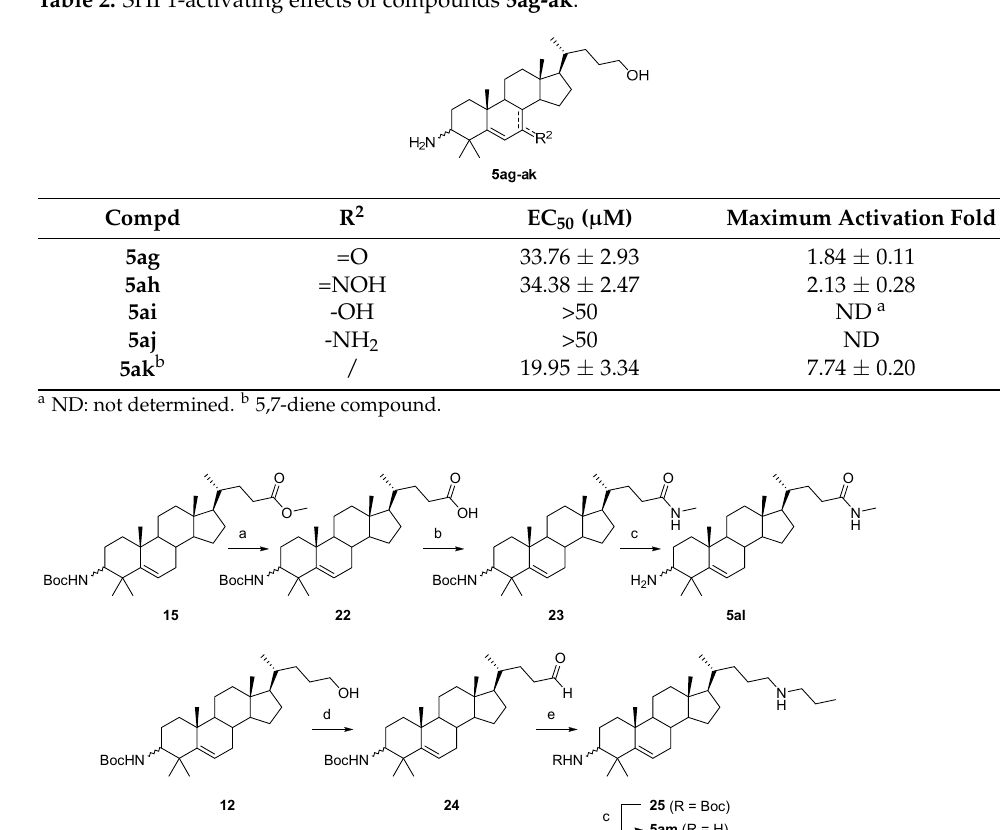
Table 2. SHP1-activating effects of compounds 5ag-ak .